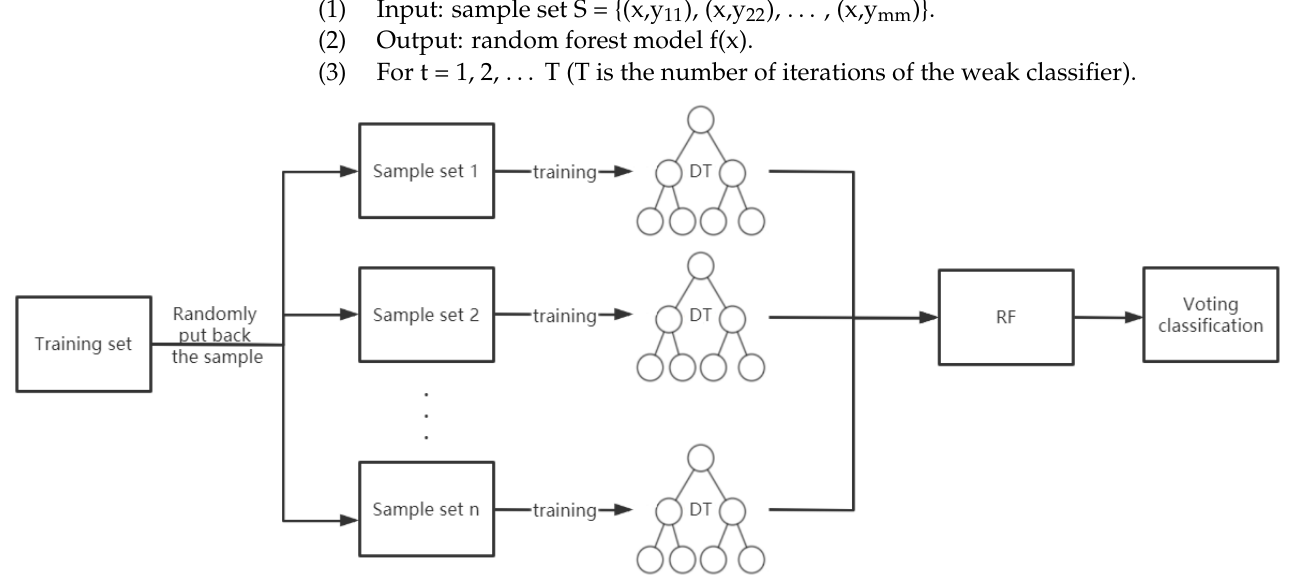
Figure 5. Basic principles of the random forest algorithm.